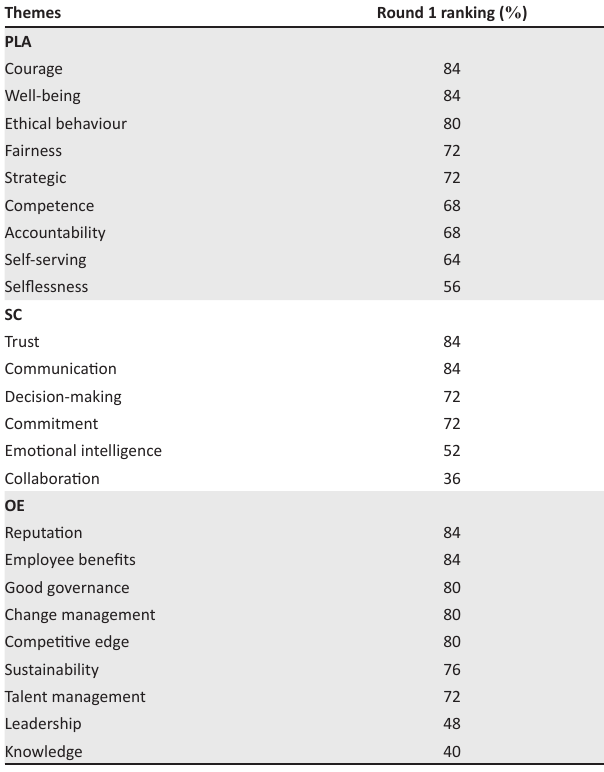
TABLE 3: Round 1 survey results in percentage for perceived leadership attributes, social capital and organisational